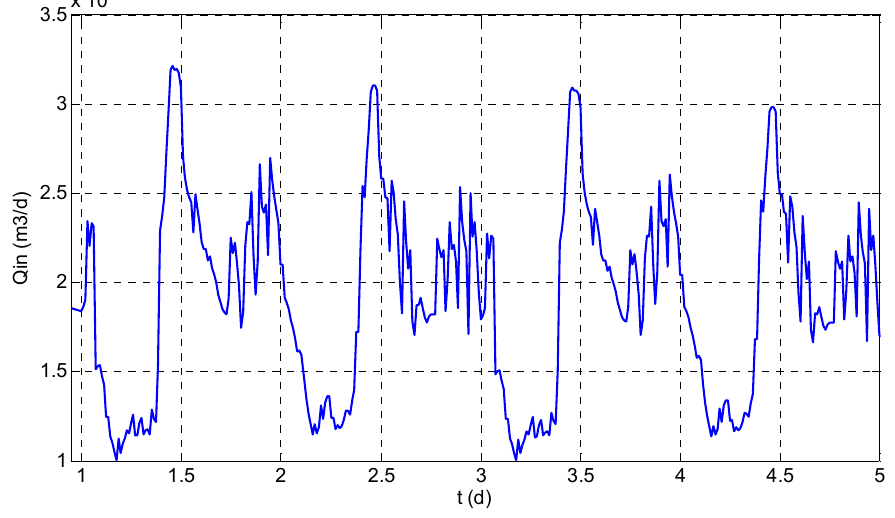
Figure 2. Influent profile for a four-day operating horizon.